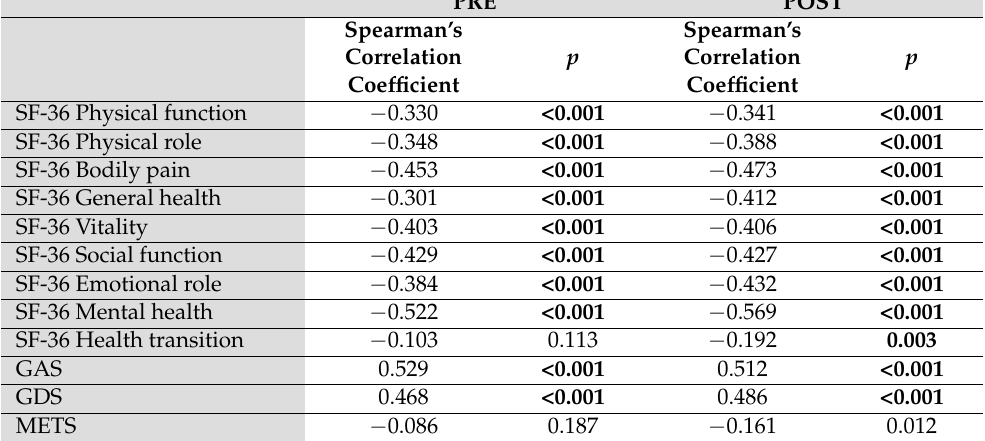
Table 3. Correlation coefficients of the initial and final values of SF-36, Goldberg Anxiety Scale, Goldberg Depression Scale and functional capacity with the Pittsburgh Sleep Quality Index.